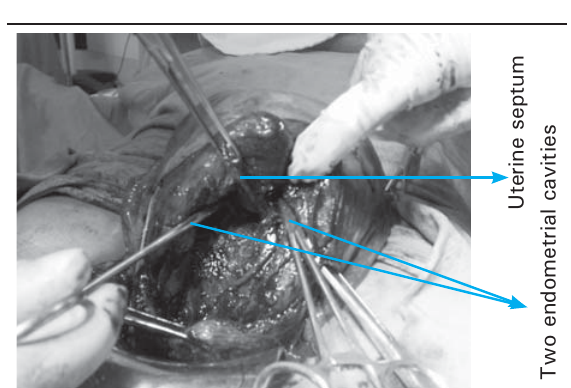
Figure 2. Two endometrial cavities divided by a septum